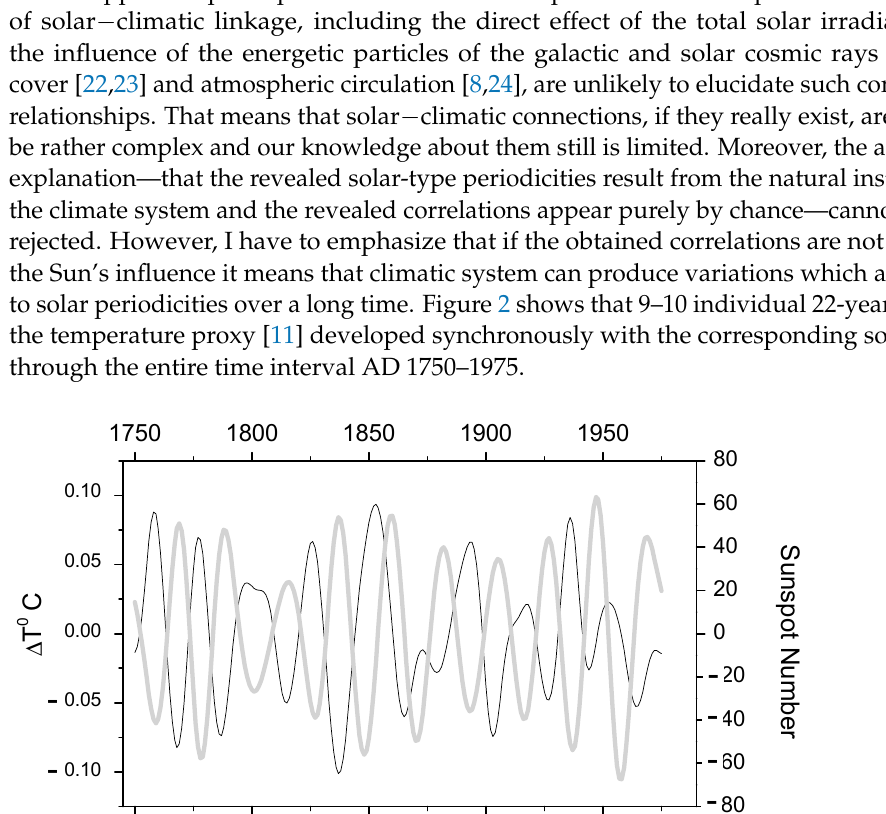
. Temperature is shifted by 1 year. N 22 S N